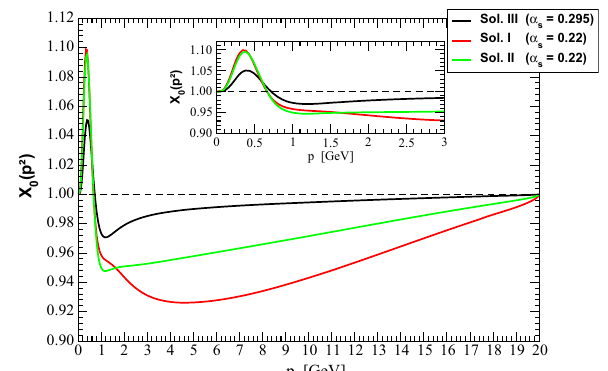
Fig. 33 The quark-ghost kernel form factor X 0 ( p 2 ) computed using α (μ) = 0 . 22 s